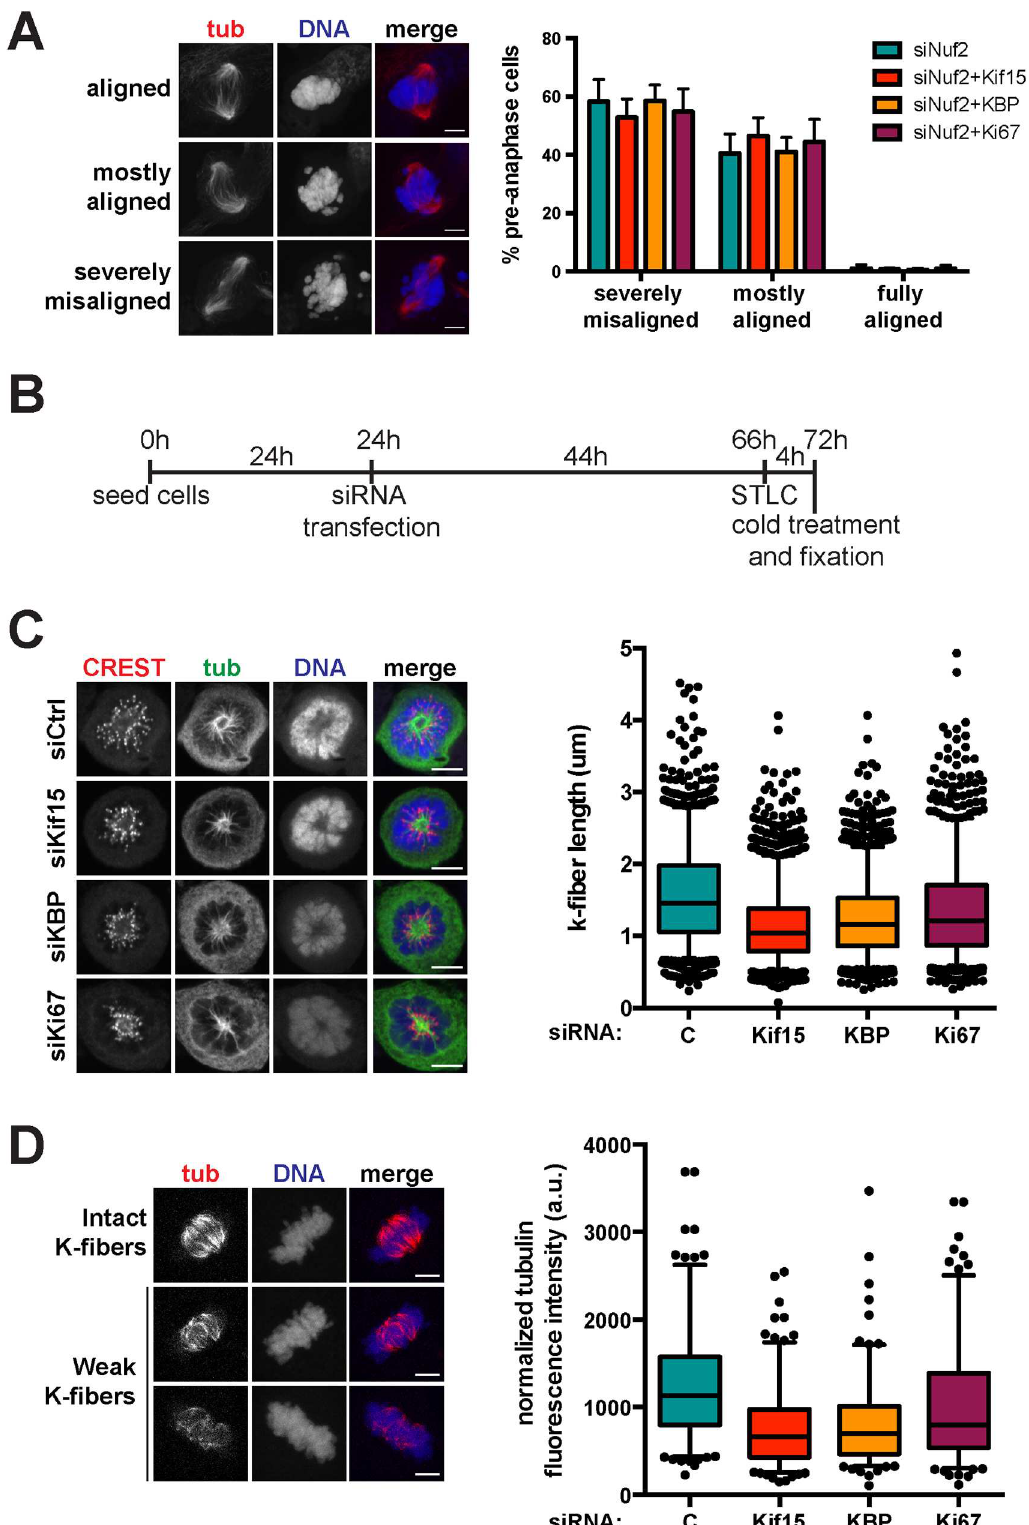
Fig 5. KBP and Kif15 affect K-fiber stability. (A) Left panel: Immunofluorescence images of Nuf2-silenced cells showingthree different categories of chromosome alignment, i.e. siNuf2 spindleswith all chromosomes